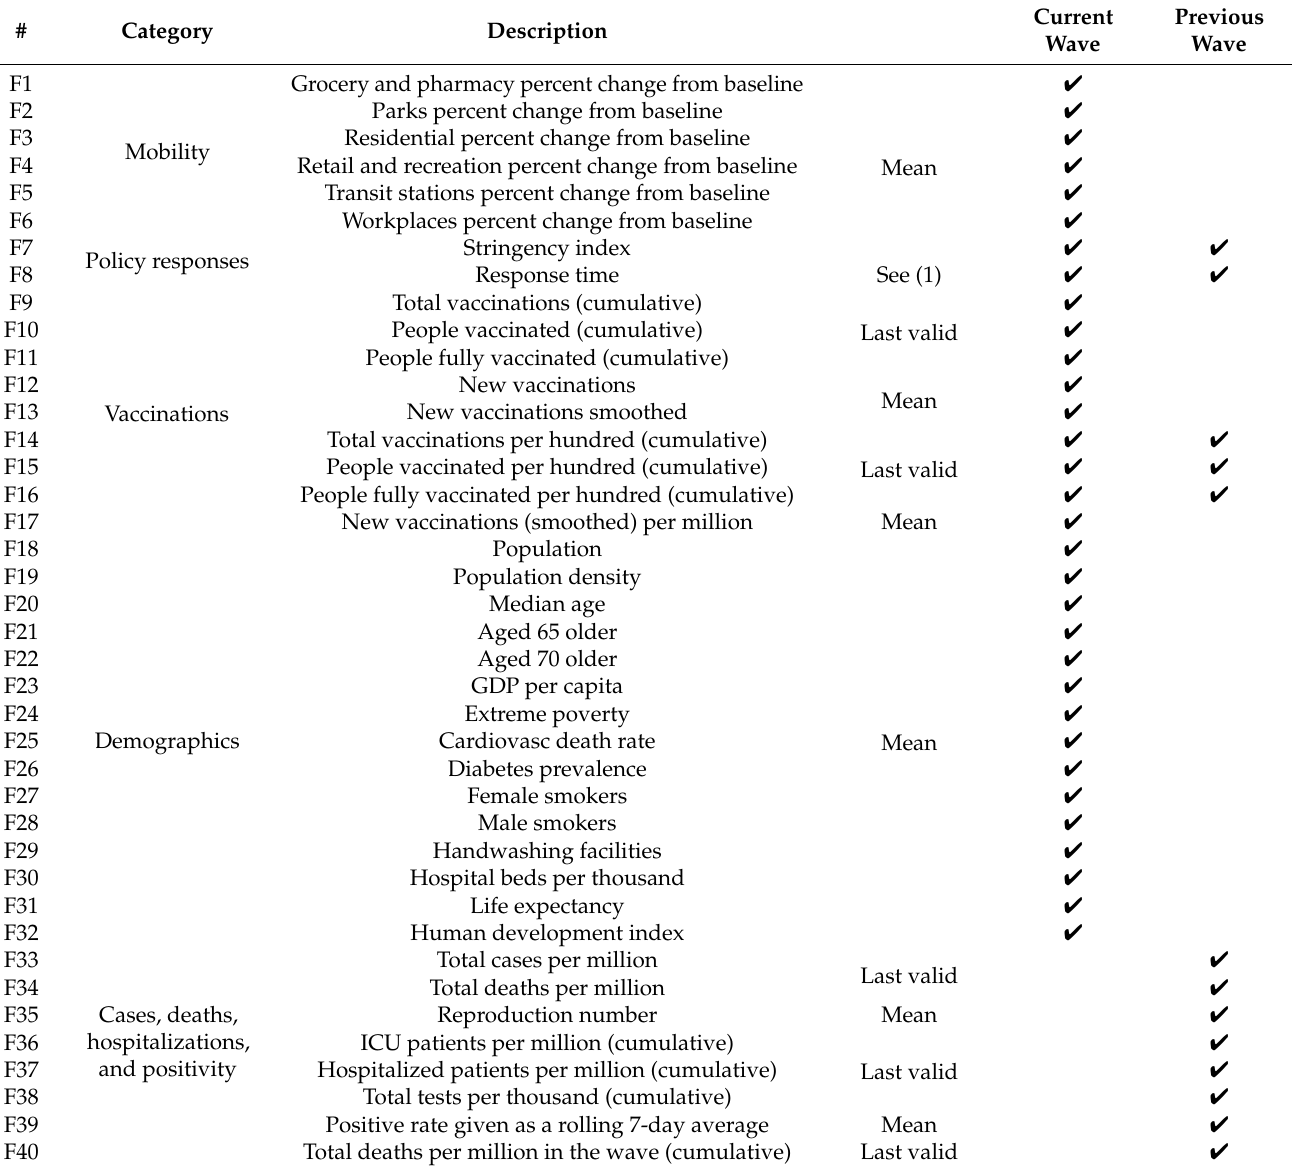
Table 2. Description of the features extracted per wave per